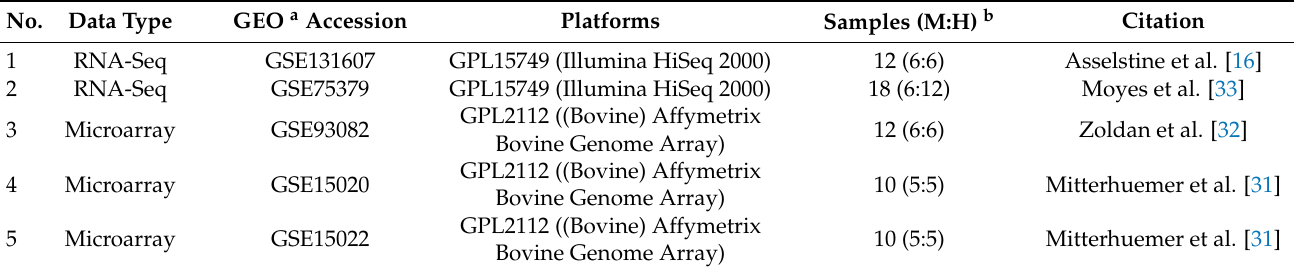
Table 1. Summary of the GEO accession numbers for RNA-Seq and microarray data